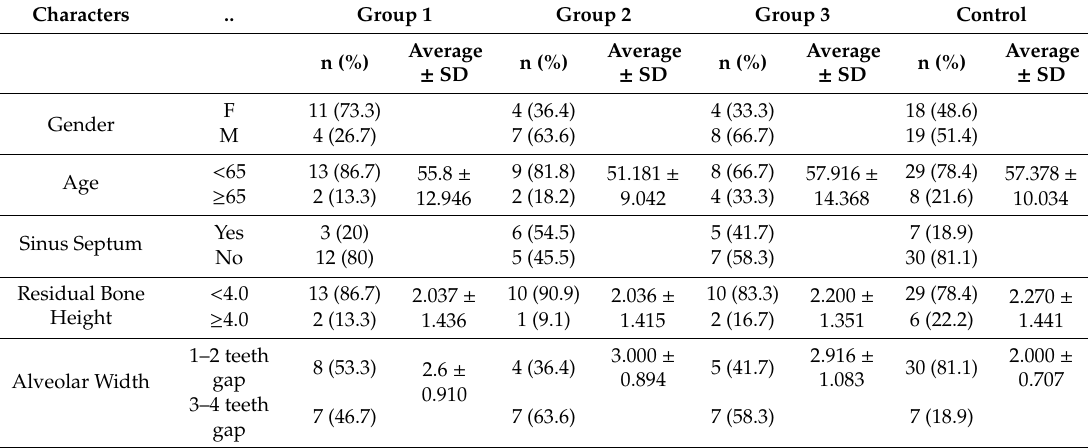
Table 1. Demographic characteristics of